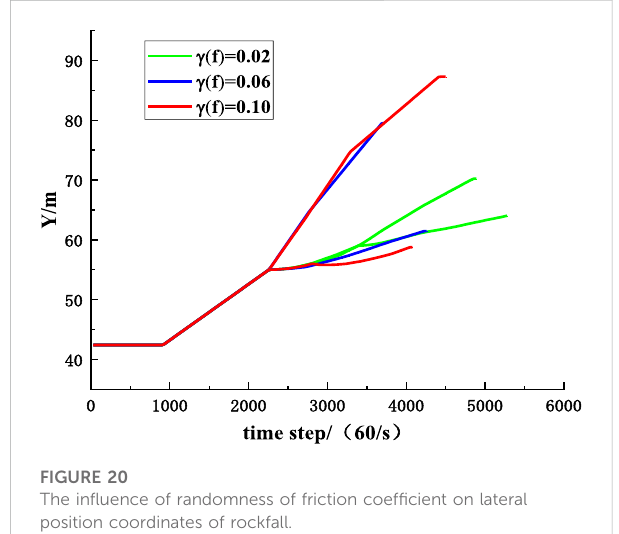
FIGURE 20 The in fl uence of randomness of friction coef fi cient on lateral position coordinates of